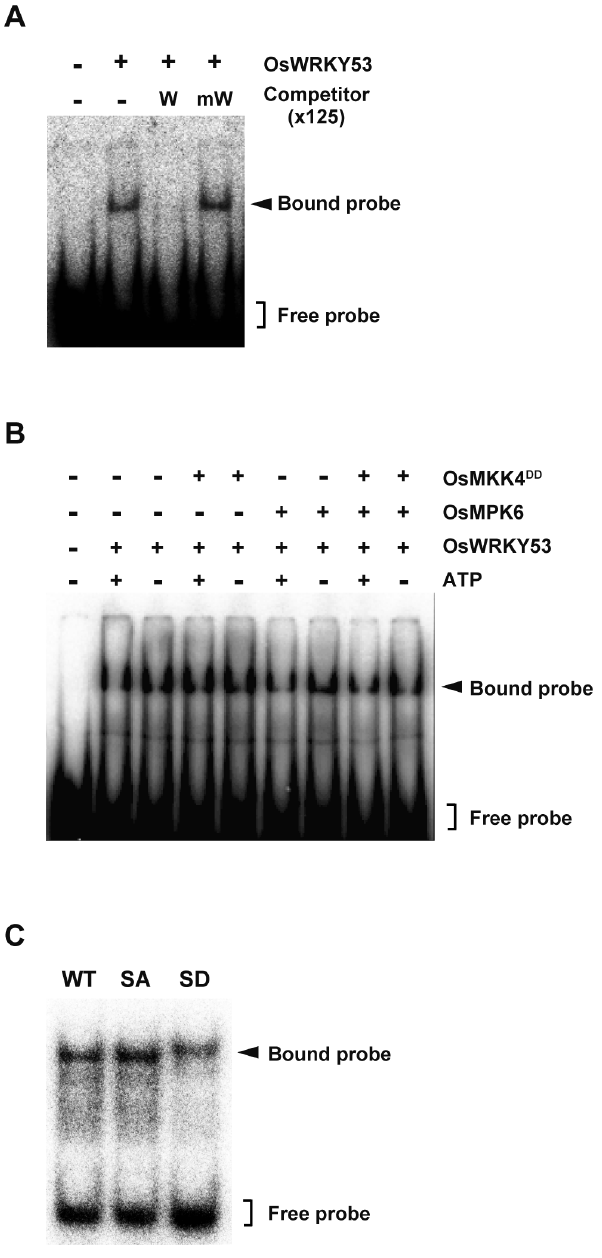
Figure 2. Phosphorylation of OsWRKY53 does not alter its W- box binding ability. A , W-box-specific DNA-binding activity of OsWRKY53. GMSA assay was performed using purified recombinant OsWRKY53 protein and 32 P-labeled W-box probe containing the W-box cis -elements in the OsWRKY53 promoter. The specificity of the W-box binding activity was demonstrated by competition assay using 125-fold excess amount of unlabeled W-box probe (W) and mutated W-box probe (mW). B , Phosphorylation of OsWRKY53 does not enhance its W- box binding activity. Purified recombinant OsWRKY53 protein was phosphorylated using the OsMPK6 activated by OsMKK4 DD . GMSA was performed as in A . C , W-box binding activity of OsWRKY53 variant proteins. Purified recombinant OsWRKY53, OsWRKY53SA and OsWR- KY53SD proteins were subjected to GMSA. GMSA was performed as in A . WT, native His-OsWRKY53; SA, His-OsWRKY53SA; SD, His-OsWR- KY53SD.